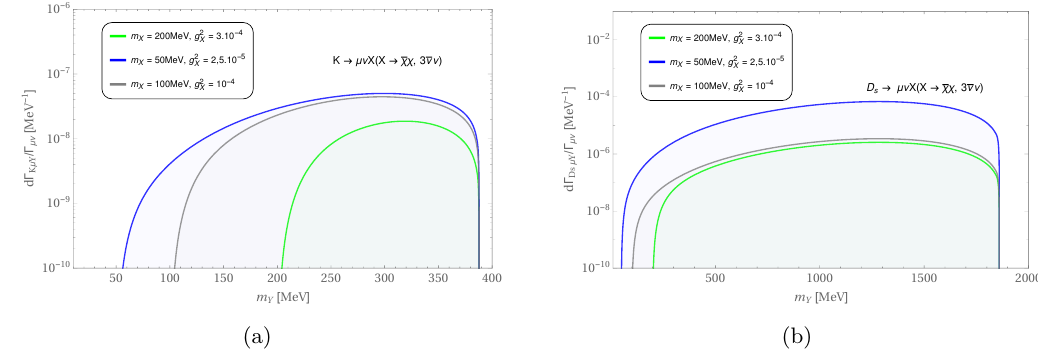
Figure 1 . The Di(cid:11)erential decay width d (cid:0) M(cid:22)Y normalized by (cid:0) (cid:22)(cid:23) for M = K; D s . The curves are plotted under the (cid:12)xed values ( c (cid:12) ; (cid:20); F (cid:22)(cid:22) ; m (cid:31) ) = (0 : 8 ; (cid:0) 4 g X ; 1 ; 3 m X ). In (cid:12)gure(b) the channel D s ! (cid:28) (cid:22) (cid:23) (cid:28) ( (cid:28) ! (cid:22)(cid:23) (cid:28) (cid:22) (cid:23) (cid:22) ) hides the distribution generated by X ! (cid:22) (cid:31)(cid:31); 3(cid:22) (cid:23)(cid:23)